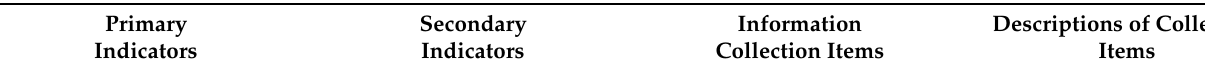
Table 2. Value Effectiveness Index Design and Collection Item Description of an Industrial Inter- net